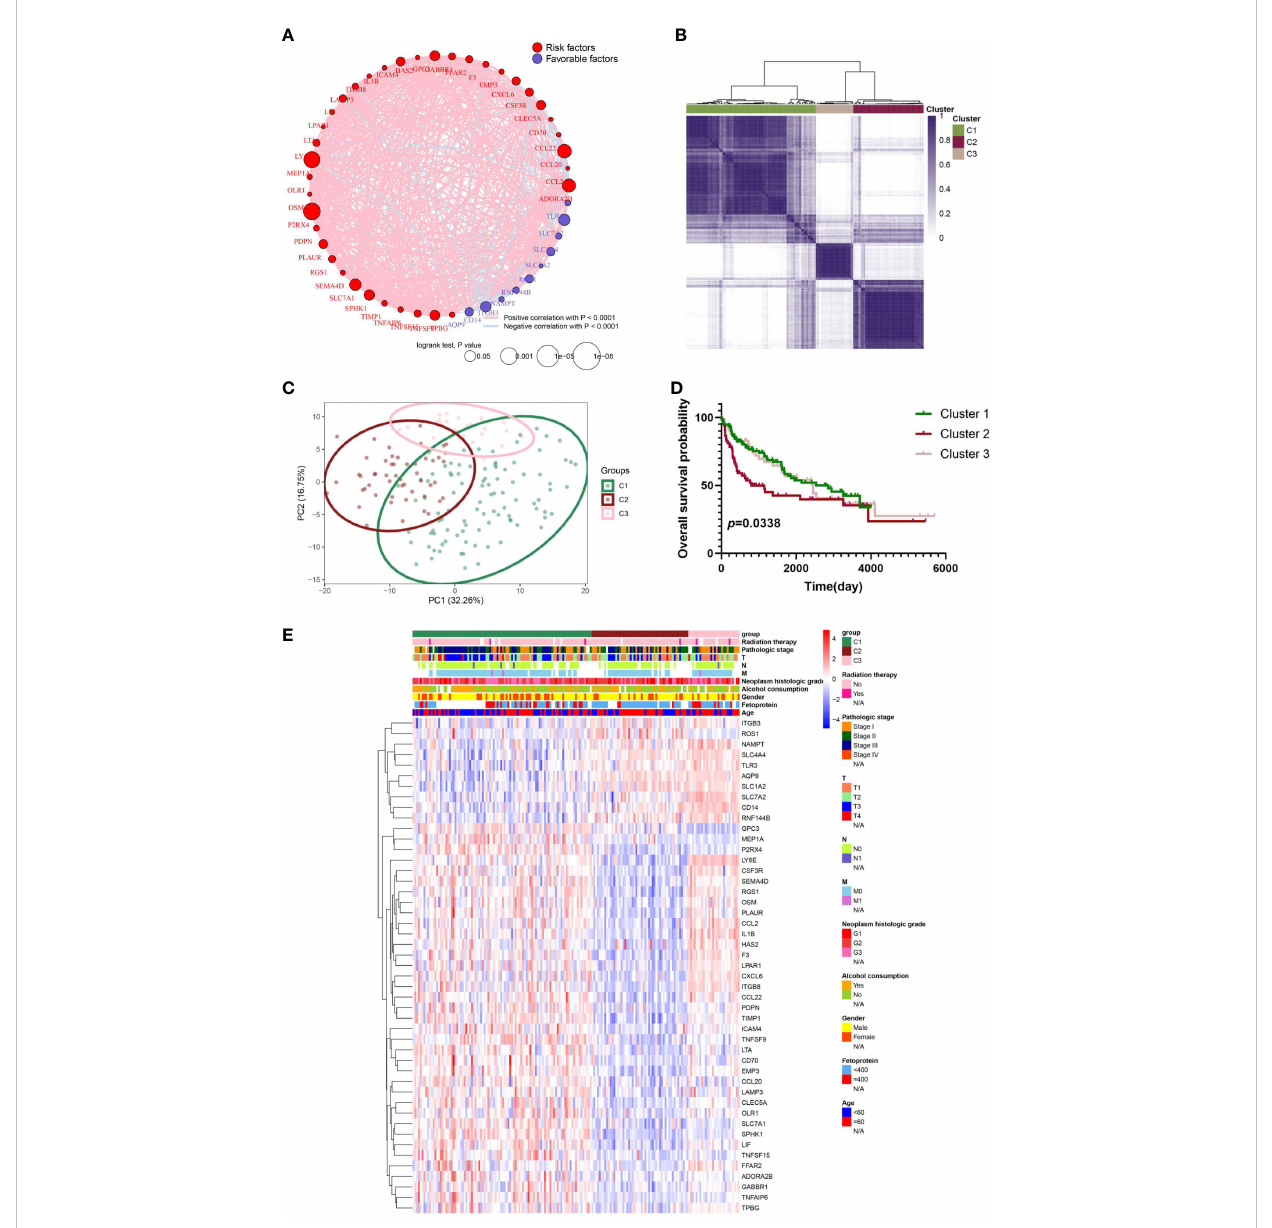
FIGURE 3 IRG subgroups divided by consistent clustering and its corresponding clinicopathological and biological characteristics. (A) The correlation in in fl ammation-related gene expression. (B) Consensus clustering of 179 sufferers from virus-related TCGA-LIHC cohorts based on the IRG DEGs. Consensus matrix for optimal k = 3. (C) Principal component analysis (PCA) of TCGA database for optimal k = 3. (D) Kaplan-Meier analysis for overall survival (OS) curves of patients in distinct clusters. (E) Differences in clinicopathologic characteristics and expression levels of IRGs between the three distinct